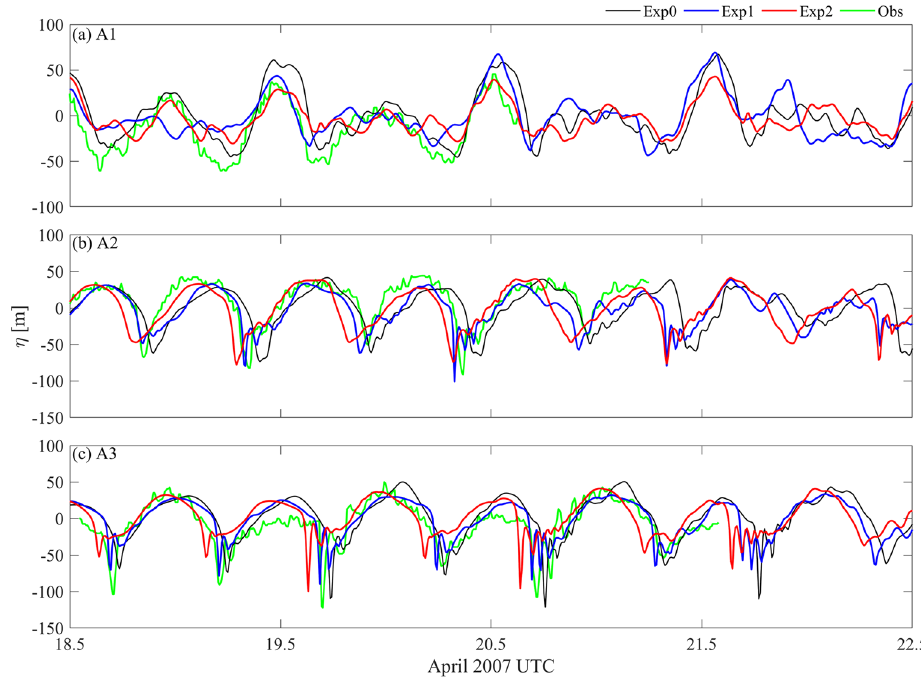
Figure 5. Time series of 9 °C isotherm displacement (units: m) of Exp0 (black lines), Exp1 (blue lines), Exp2 (red lines) and observations in Li (2014, green lines) at ( a ) A1, ( b ) A2 and ( c ) A3 (shown in Fig.